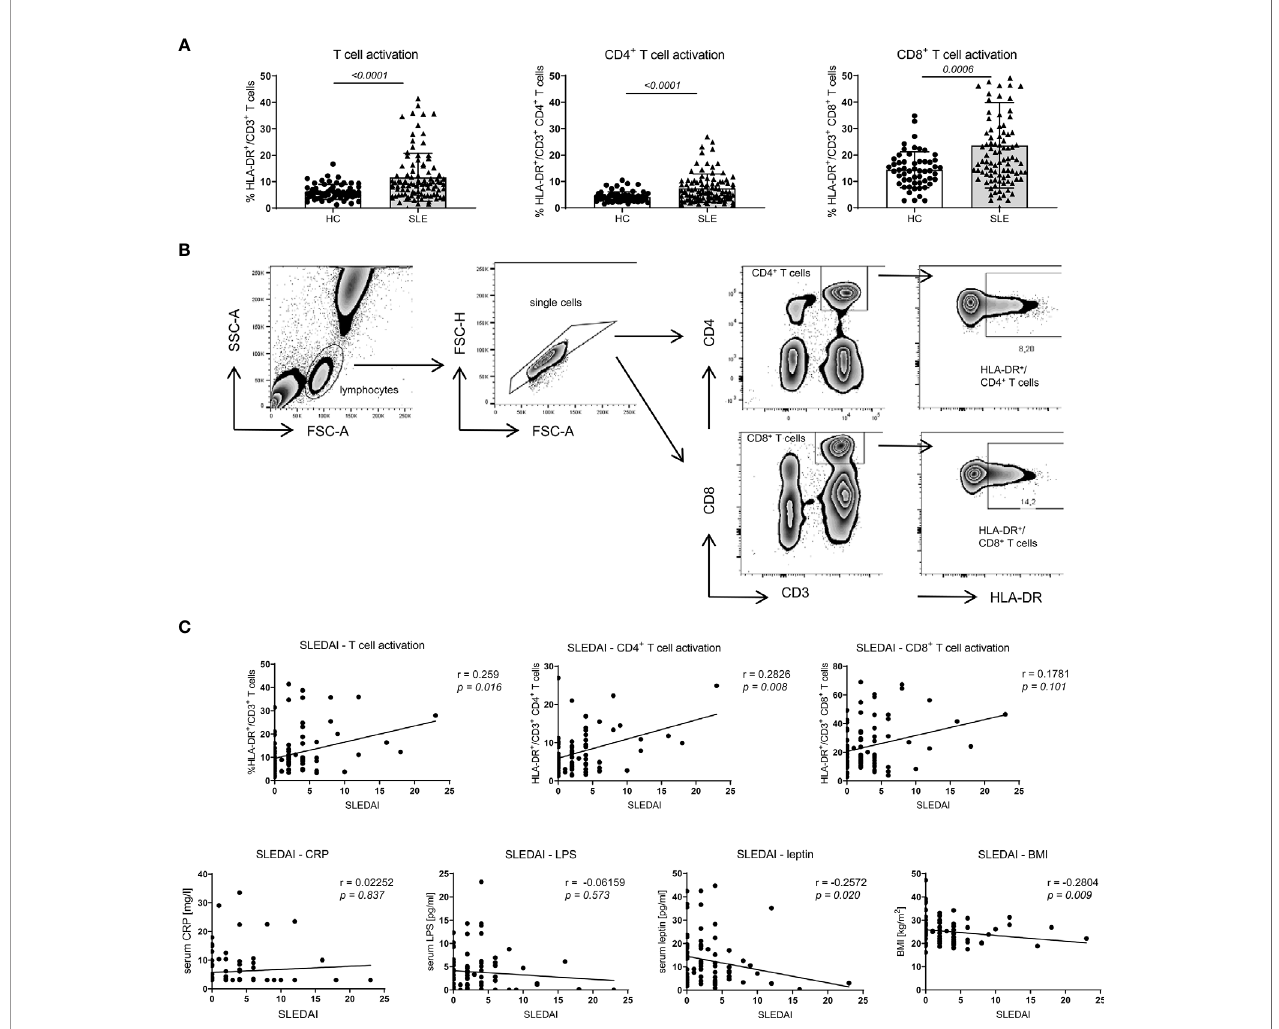
FIGURE 5 | Association between SLE activity, obesity, intestinal leakage, in fl ammation and adaptive immune activation. (A) Comparison of HLA-DR expression as marker of immune activation on CD3 + , CD3 + CD4 + and CD3 + CD8 + T cells in SLE patients (n = 86) and healthy controls (HC; n = 67). Results are expressed as scatter blots with mean ± SEM; each data point represents an individual donor; p <0.05 was considered signi fi cant. (B) Representative FACS-blots indicating the selection of lymphocytes, doublet-exclusion, selection of CD3 + CD4 + or CD3 + CD8 + T cells and expression analysis of HLA-DR. (C) The relationship between disease activity (SLEDAI) and obesity (BMI and serum leptin), systemic in fl ammation (CRP), gut leakage (serum LPS) as well as adaptive immune activation (% HLA-DR expression on CD3 + , CD3 + CD4 + and CD3 + CD8 + T cells) was analyzed by Spearman ’ s rank correlation; graphed are numerical values, Spearman ’ s rank correlation coef fi cient and its